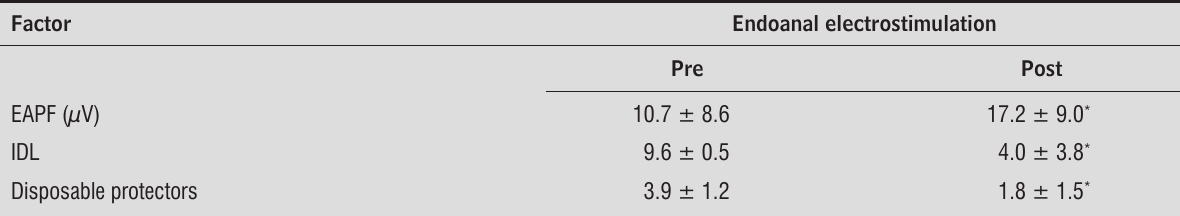
jan/mar;27(1):93-100Electrostimulation, Table 1 - Mean and standard deviations of the electrical activity of the pelvic floor (EAPF), interference with daily life (IDL), and amount of disposable protectors used before and after 16 sessions of endoanal